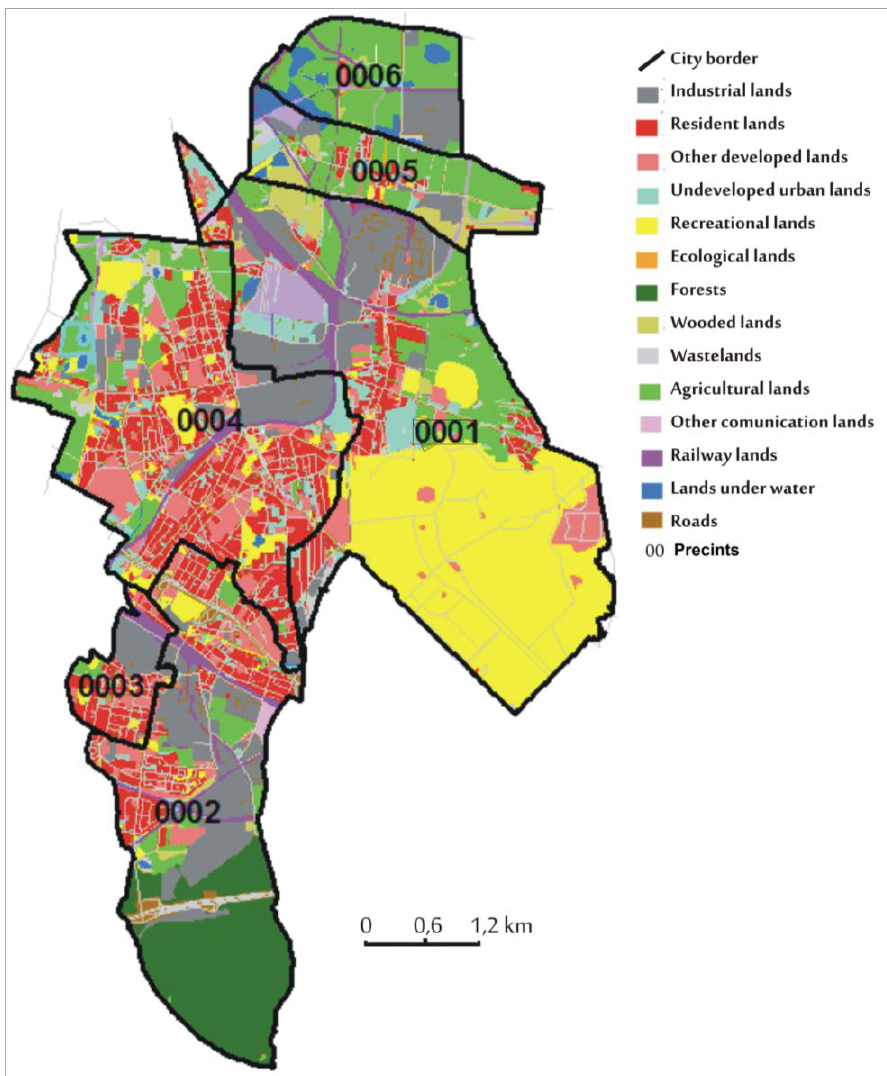
Fig. 3. Spatial structure of Chorzów